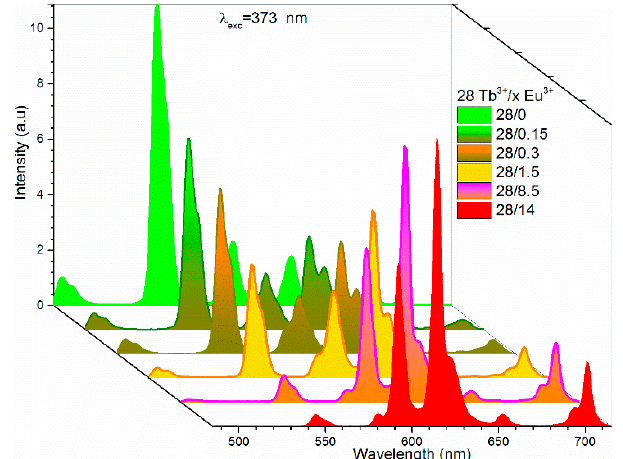
Figure 4. Emission spectra of the Tb 3+ /Eu 3+ -codoped ceramic phosphor plate excited at 378 nm.